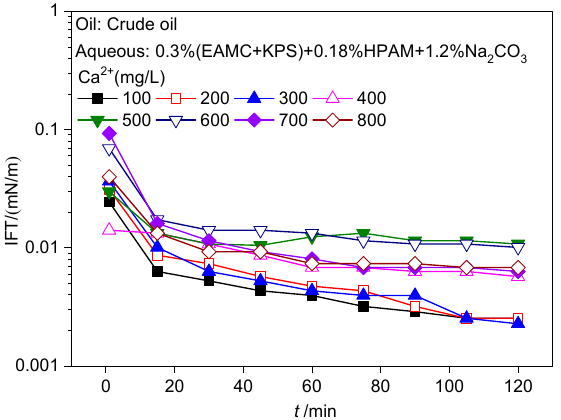
Figure 7. The effect of Ca 2+ on the dynamic IFTs of chemical flooding solutions.